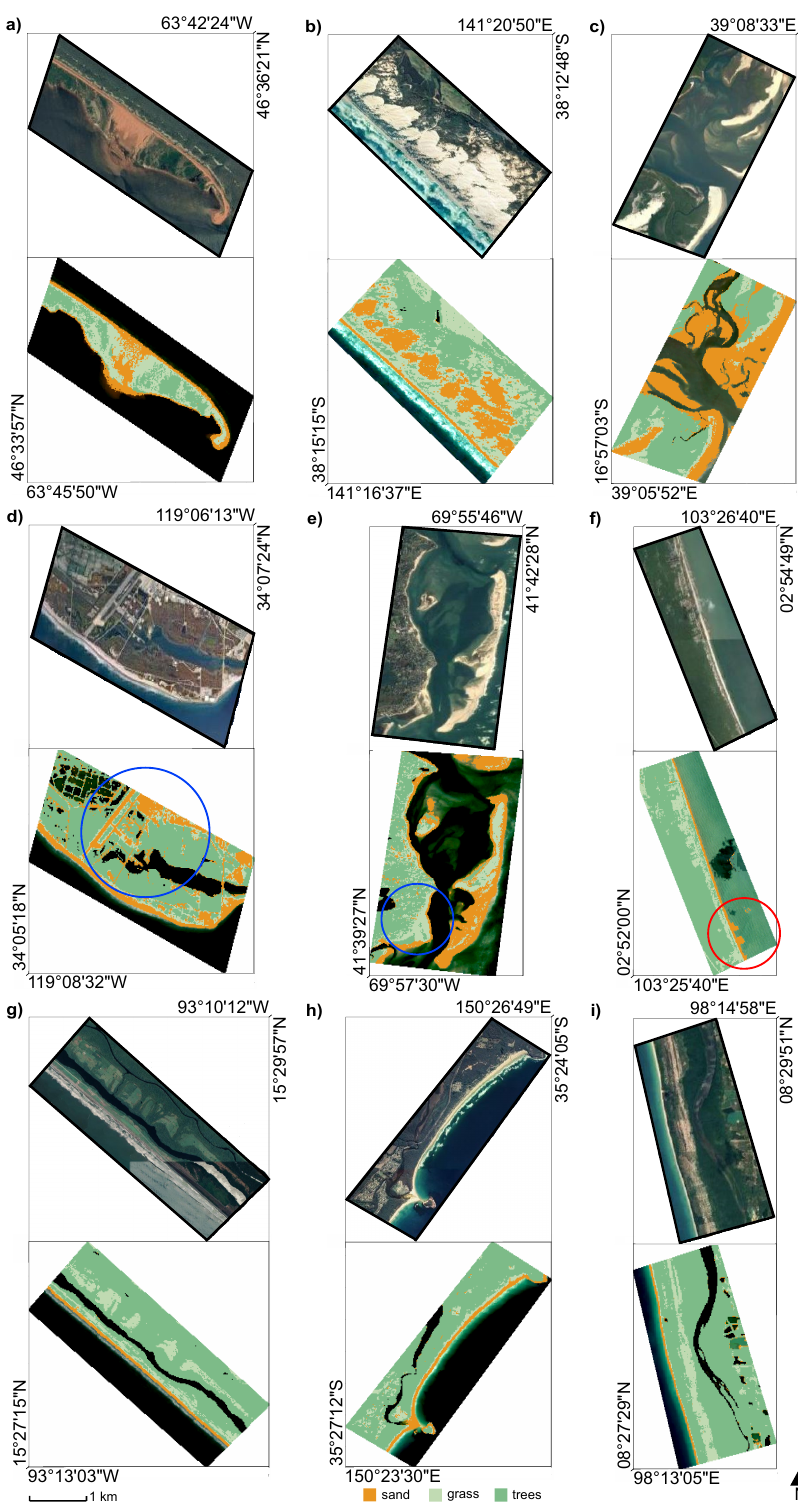
Figure 6. Comparison between very high-resolution satellite images from Google Maps and the classification based on Sentinel-2 for a selection of AoIs (EPSG: 4326): ( a ) New Bedford, MA, USA; ( b ) Discovery Bay Coastal Park, Australia; ( c ) Moebase, Mozambique; ( d ) Point Mugu, CA, USA; ( e ) Chatam, MA, USA; ( f ) Kuala Rompin, Malaysia; ( g ) El Palmarcito, Mexico; ( h ) Shoalhaven, Australia; ( i ) Lampi–Hat Thai Mueang National Park, Thailand. The blue circles in the panels ( d , e ) indicate urbanized areas, whereas the red circles in the panel ( f ) indicate misclassification of the sand–sea